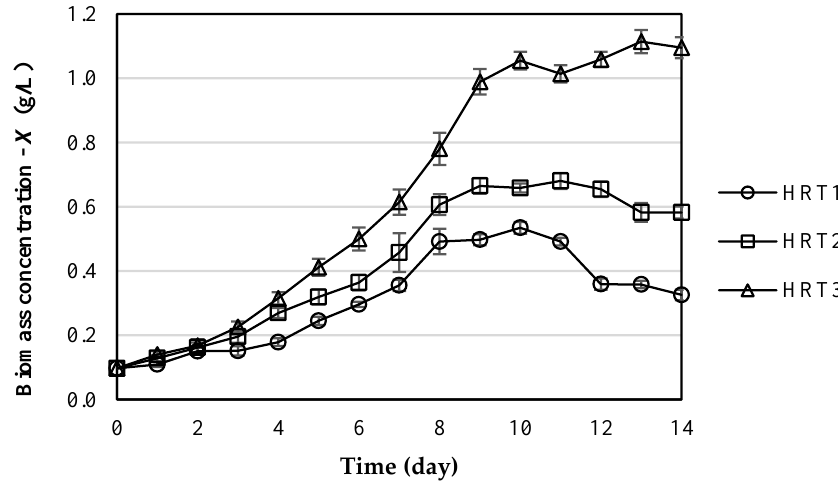
Figure 2. The growth of Chlorella vulgaris in the pilot-scaled MPBR with 2-fold diluted piggery wastewater in 14 days at three hydraulic retention times (HRT1 = 1.25 days, HRT2 = 2.5 days, HRT 3 = 5 days). In comparison with other MPBR systems, at a similar HRT of 4.6 days in a 20 L photo- bioreactor, the co-culture of A. platensis and C. vulgaris in 20% ( v / v ) winery wastewater with Bold’s Basal Medium achieved a much larger biomass concentration at Day 15 (above 5 g/L) which was 5-fold larger [15]. It is noted that the 20% winery—BBM mixture had lower COD (119.3) and TSS (0.75) concentrations compared to this study. This could be the result of a much harsher cultivating medium for a single culture of C. vulgaris in this study where the piggery wastewater was only 2-fold diluted with DI water. The COD content of piggery digestate often composed the remaining fatty acid from the anaerobic digestion and might require longer effort to be broken down than the alcohol and sugar components in the winery wastewater. The observed lag phase in the early stage of each HRT might be the result of relatively low inoculum (initial biomass was around 0.1 g/L) before direct continuous feeding of the wastewater mixture. This phase was absent in other studies where the larger inoculum and batch-mode cultivation were adapted [6,7,15,31]. The hydraulic retention time was the significant factor that affected the growth of C. vulgaris in the wastewater mixture in this study. The longer retention time resulted in higher final biomass concentration (0.326 ± 0.016 g/L to 1.095 ± 0.033 g/L as the HRT increased from 1.25 days to 5 days). The growth characteristics were also improved at longer HRT (Table 2). The specific growth rate and biomass productivity increased from 0.086 ± 0.004 d − 1 to 0.173 ± 0.002 d − 1 and 0.016 ± 0.001 g/L.d to 0.071 ± 0.002 g/L.d, respectively. This result is in good agreement with other studies that employed continuous photobioreactors, which observed a similar pattern [15,32]. In contrast, Gao et al. reported that shorter HRT resulted in an increase in biomass in the cultivation of C. vulgaris in artificial wastewater [12]. The biomass concentration increased from 0.481 to 0.873 g/L as the HTR was shortened from 6 to 1 day in the artificial wastewater condition of 40 mg/L COD, 5 mg/L NH 4+ , and 10 mg/L PO 43 − . The opposite findings between Gao et al. and this study might be answered by the significant difference between the wastewater conditions. The longer HRT could either exhibit higher or lower growth of microalgae in the MPBR system, and it depended on the characteristic of the wastewater. Larger flowrates presented much harsher conditions of nutritional (NH 4+ ) and conditional stress (larger COD and TSS fed) to the C. vulgaris culture, resulting in a lower biomass concentration and productivity. Long HRT favors the microalgae growth with the excessive organic content and nutrients and, meanwhile, idles the growth with the inadequate nutrient supply. The much larger reactor volume (50 L) could be another reason for the